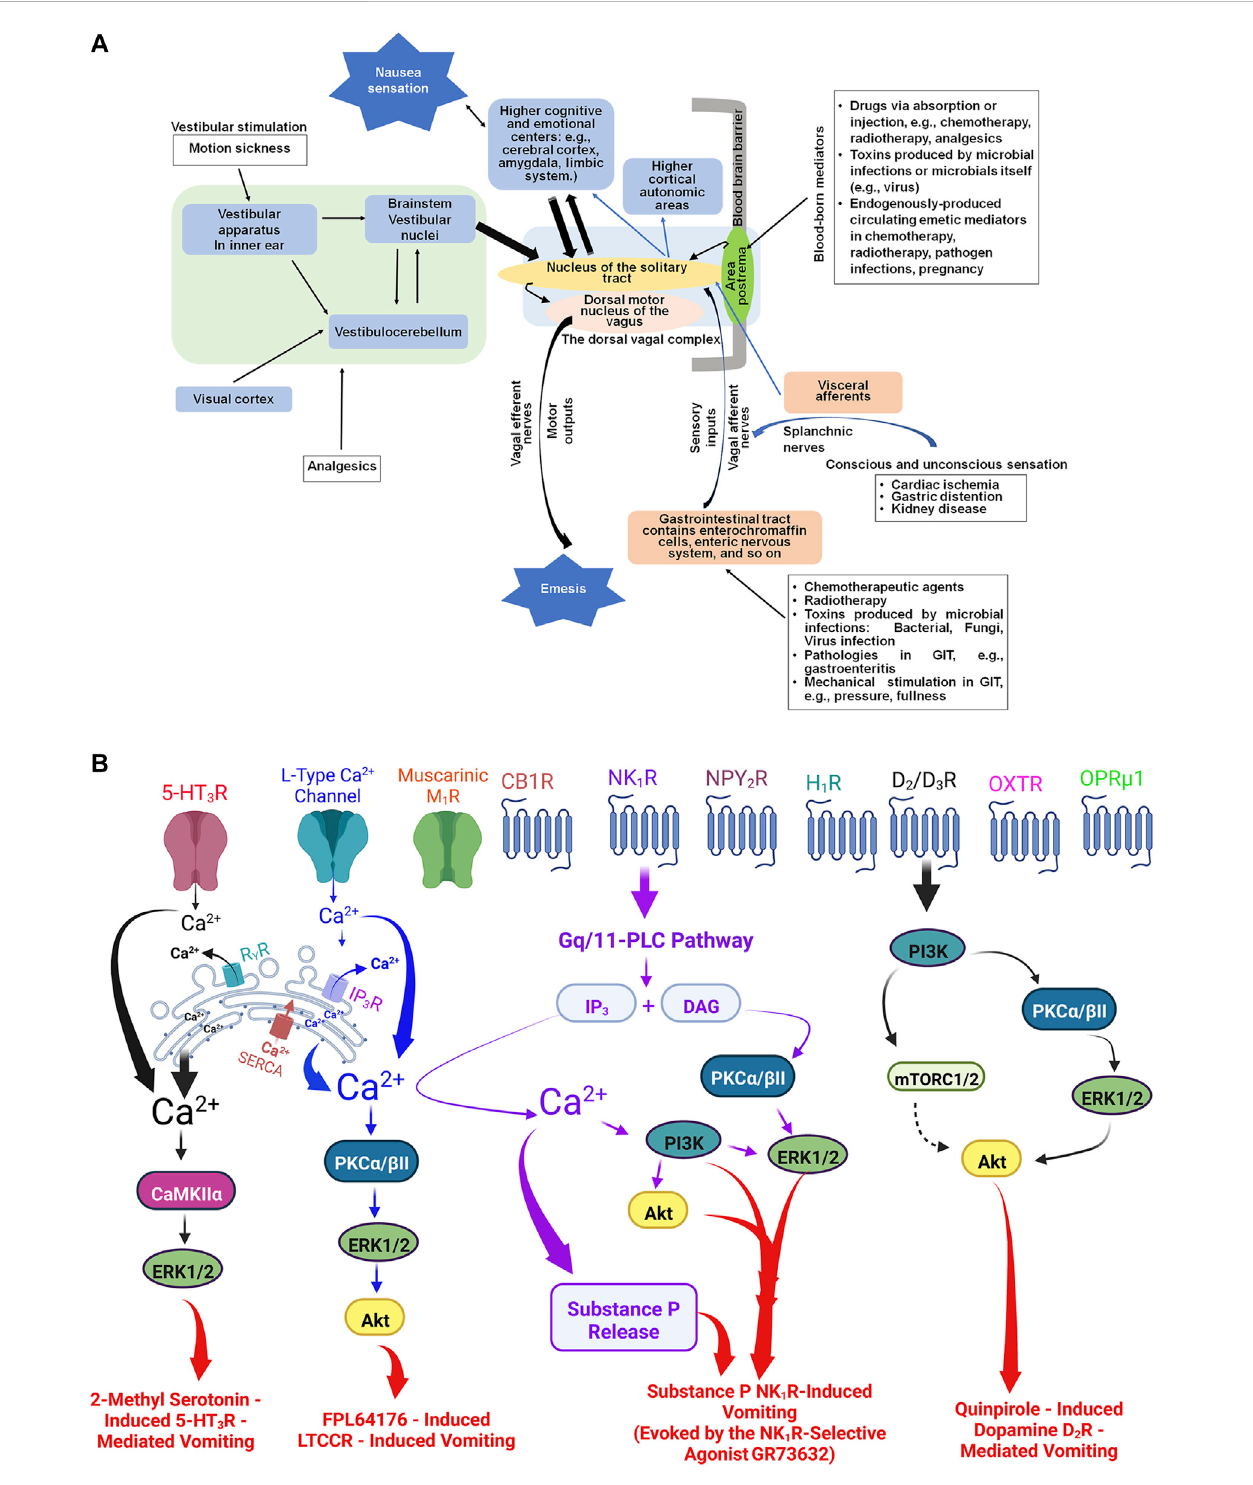
FIGURE 7 (A) : The central and peripheral anatomical sites in the mediation of nausea and vomiting evoked by diverse stimuli. Following exposure to various emetics, nausea and vomiting can be generated via bidirectional interactions between brain and the gastrointestinal tract (GIT). Brie fl y: 1) the brainstem area postrema in the fl oor of the fourth ventricle lacks blood brain barrier and allows circulating emetogens direct entry from the circulating blood into the cerebrospinal fl uid and the brain tissue (Wickham, 2020); 2) systemically administered emetogens can activate corresponding receptors present on peripheral vagal afferents in the gastrointestinal tract, which project sensory emetic signals to the nucleus of the solitary tract (Navari, 2014; Wickham, 2020); and 3) peripheral emetics that enter the lumen of GIT such as cytotoxic chemotherapeutics, or microbials (e.g., bacteria, viruses, fungi), as well as gastrointestinalpathologies,cancausereleaseoflocalemeticneurotransmitters/hormones,whichsubsequentlyactonthecorrespondingreceptorspresent onvagalafferentsand/ordirectlystimulatethebrainstemareapostrema via circulatingblood(BashashatiandMcCallum,2014;McKenzieetal.,2019).Besides the area postrema and the sensory vagal afferents, the nucleus of the solitary tract is also the recipient of: i) direct neural inputs from the splanchnic nerves